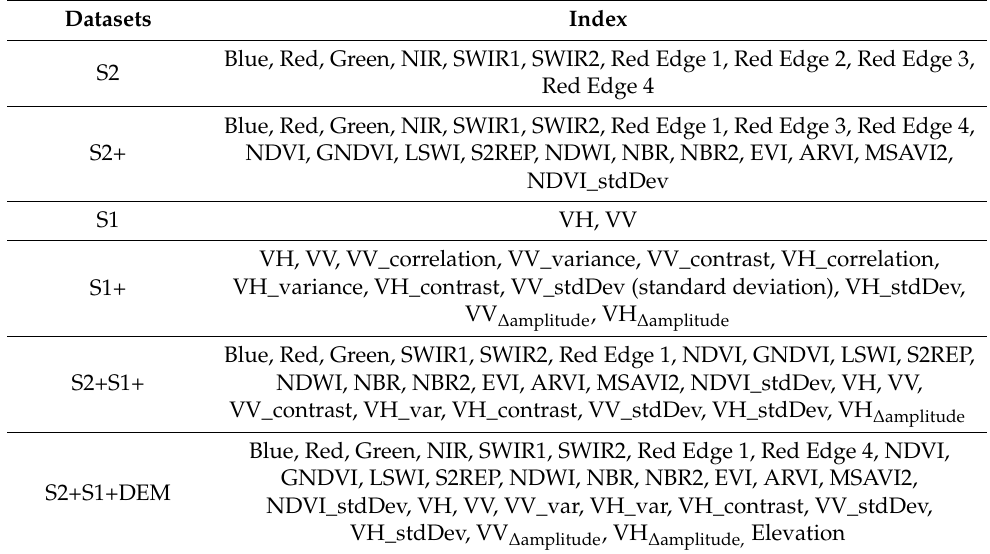
Table 4. Image features retained for land cover